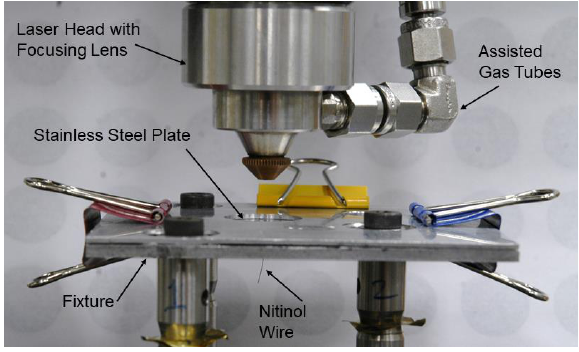
Figure 8: Actual setup for drilling thin nitinol wires to restore semi- infinite material